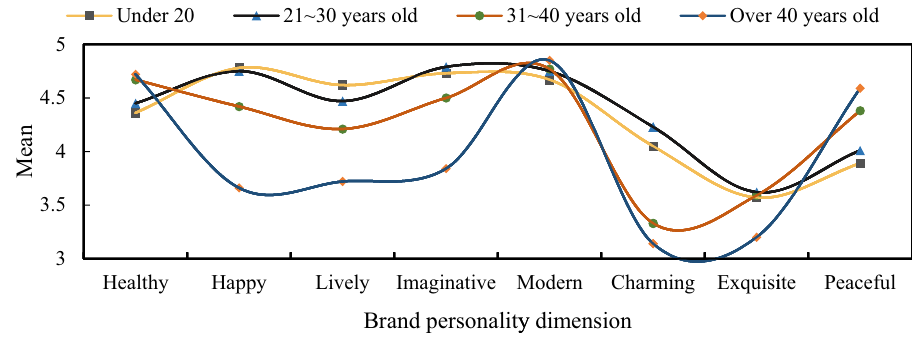
Figure 6: Age and brand personality in an eight - dimensional attitude